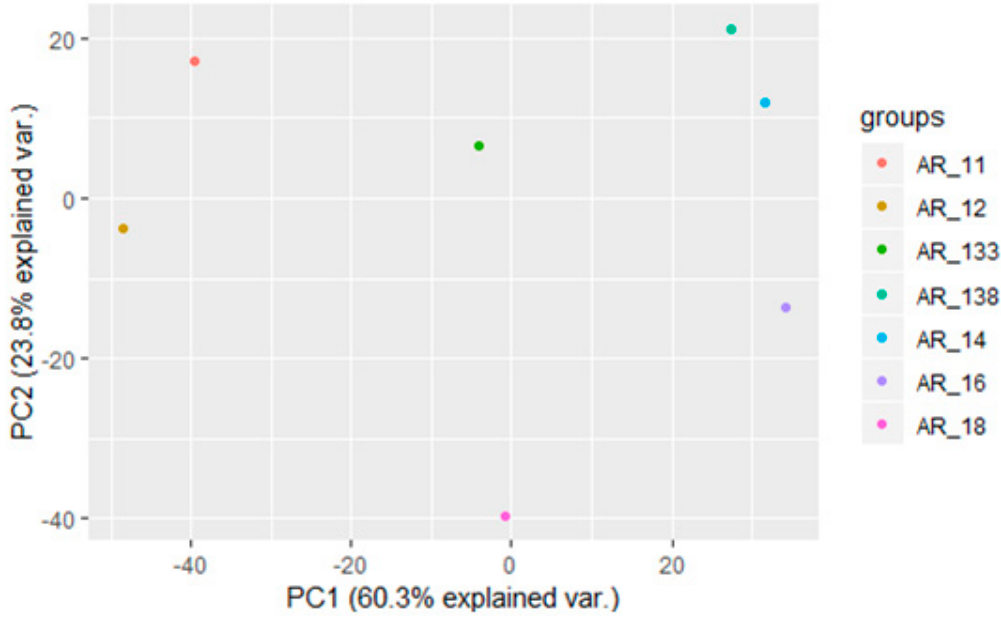
8 of 14 Figure 3. Principal component analysis (PCA) of mean values for the 1900 absorbance values of FT- NIR spectra for the seven maturity levels of “Victoria” grape: 16.9° (V106), 14.9° (V149), 14.2° (V142), 11.9° (V119), 11.6° (V116), 10.6° (V106), and 9° (V9) Brix. Grouping found in the PCA reflects the maturity levels of the samples. Indeed, the lowest maturity samples are grouped in the positive quadrant of the PCA, the intermediate (around 11° Brix) in the second quadrant, the two highest maturity samples are in the negative quadrant, and the 14.2° Brix sample is in the fourth quadrant. Large spectral regions give a strong contribution to the positive PC1 axis: 11,548–10532, 9600–9112, 7208–6488, 5328–4772, and 4228–3952 cm − 1 . Three of these regions can be attributed to water signals; indeed the 10,500 and 6900 cm-1 regions are related